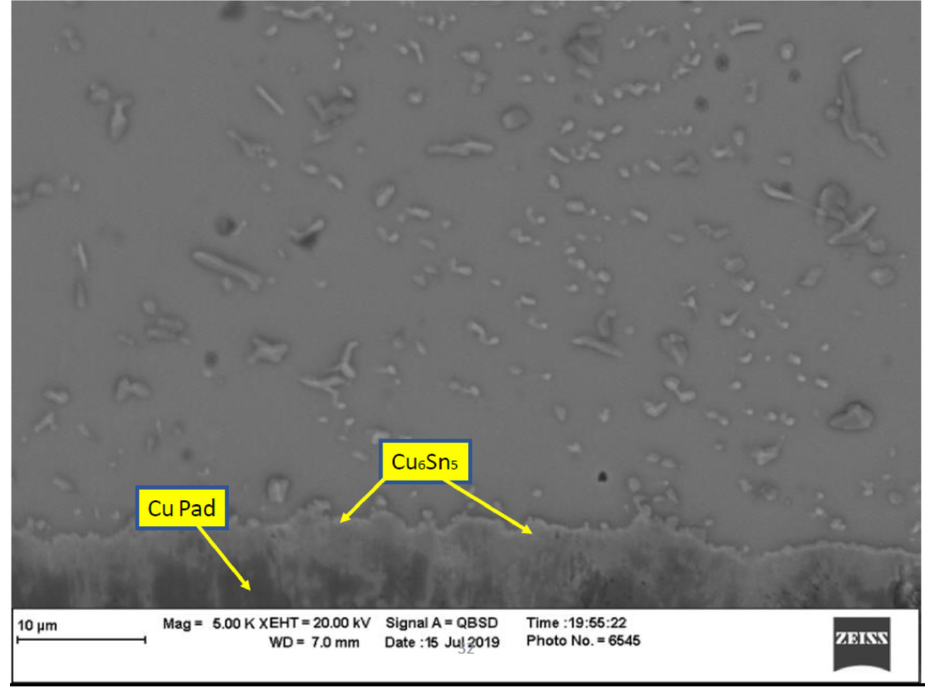
Figure 8. Microstructure of the junction zone between Cyclomax and the copper pad of a sample that underwent heat aging for 100 h.